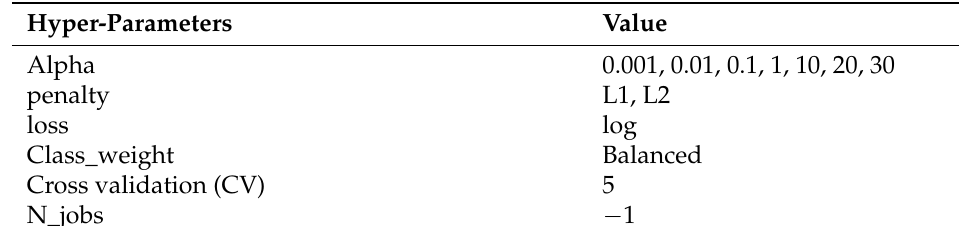
Table 7. Input Parameters for Logistic Regression.